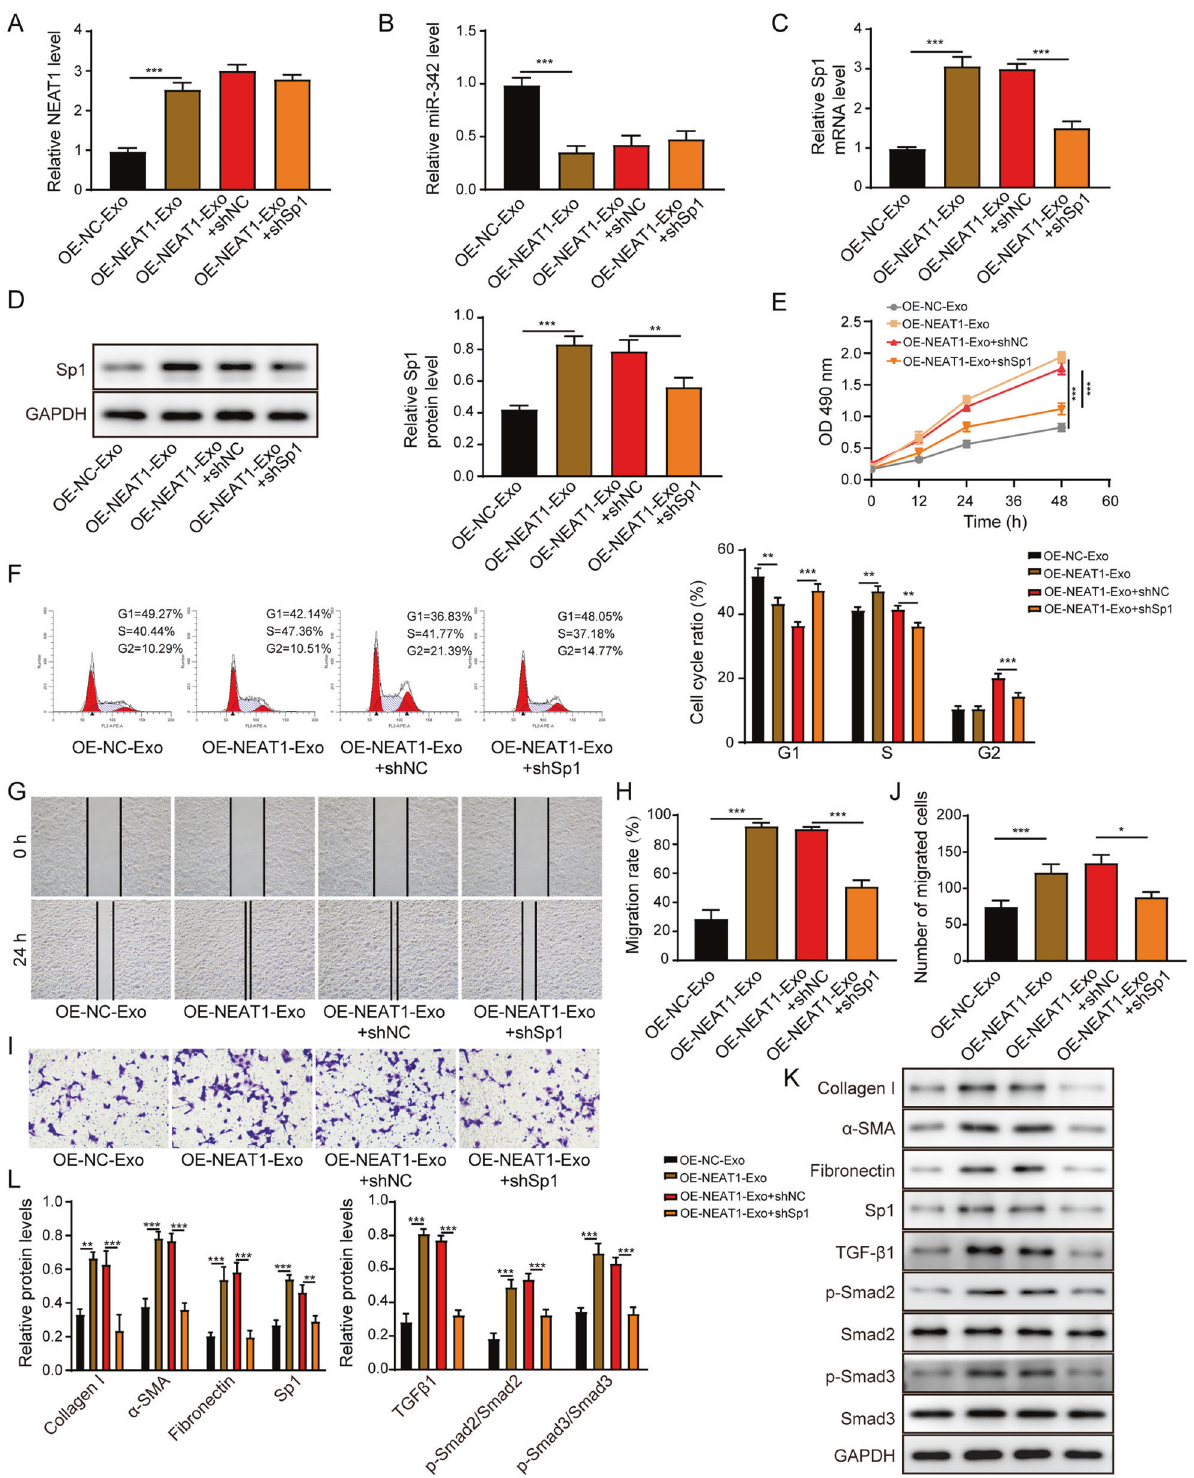
Fig. 9 Exosomal NEAT1 from THP-1 macrophages facilitates HSCs activation via mediating Sp1. A , B The NEAT1 ( A ) and miR-342 ( B ) expression levels in LX-2 cells were assessed via qRT-PCR. C , D Sp1 mRNA ( C ) and protein ( D ) levels were determined using qRT-PCR and western blot, respectively. E The LX-2 cell proliferation was examined by the CCK-8 assay. F The cell cycle of the LX-2 was examined by the fl ow cytometry. G – J The migration of LX-2 was determined by the scratch assay ( G , H ) and the transwell assay ( I , J ). K , L The protein levels of collagen I, α -SMA, fi bronectin, Sp1, TGF- β 1, p-Smad2, Smad2, p-Smad3 and Smad3 were measured by western blot. * p < 0.05; ** p < 0.01; *** p < 0.001.